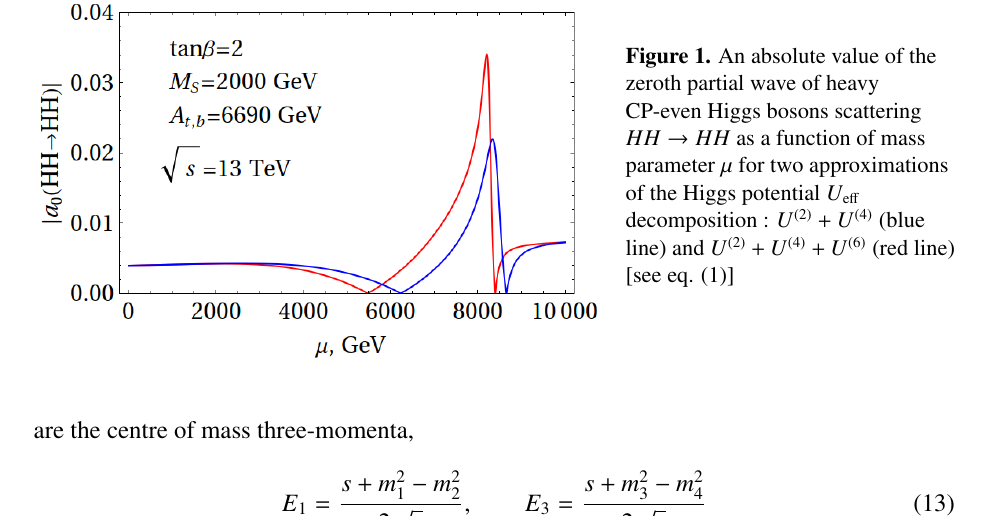
Figure 1. An absolute value of the zeroth partial wave of heavy CP-even Higgs bosons scattering HH HH as a function of mass → parameter µ for two approximations of the Higgs potential U e ff decomposition : U (2) + U (4) (blue line) and U (2) + U (4) + U (6) (red line) [see eq.